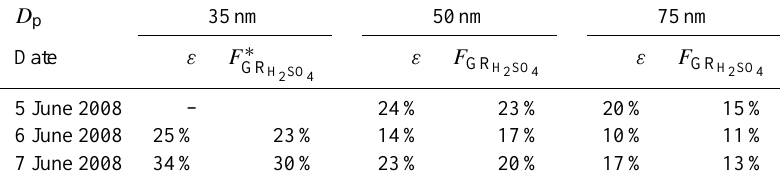
Table 3. The water-soluble fraction of newly formed particles and the ratios of H 2 SO 4 condensational growth to the observed particle growth. D p